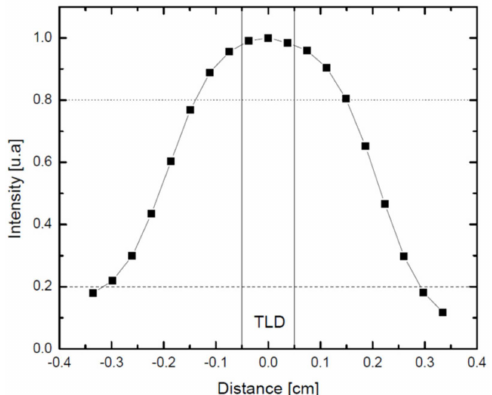
Figure 3. Profile of a EBT3 radiochromic film irradiated with a circular field with a diameter of 4 mm. The lines represent the width of a TLD-100